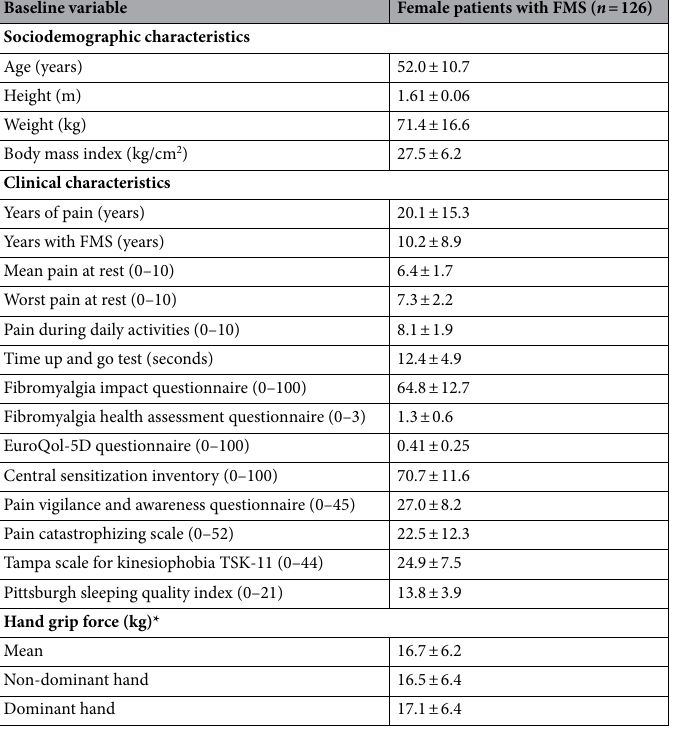
Table 1. Baseline outcomes (mean ± SD) of the sample. *No side-to-side differences ( p =